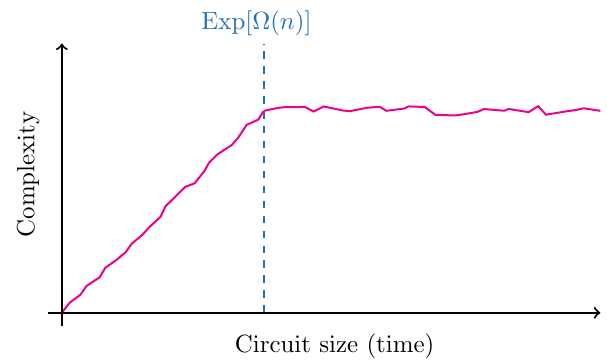
FIG. 1. Expected complexity growth in random circuits. Con- jecture 1 states that, for random quantum circuits acting on n qubits, the circuit complexity grows linearly with circuit size (time) until it saturates at a value exponentially large in n